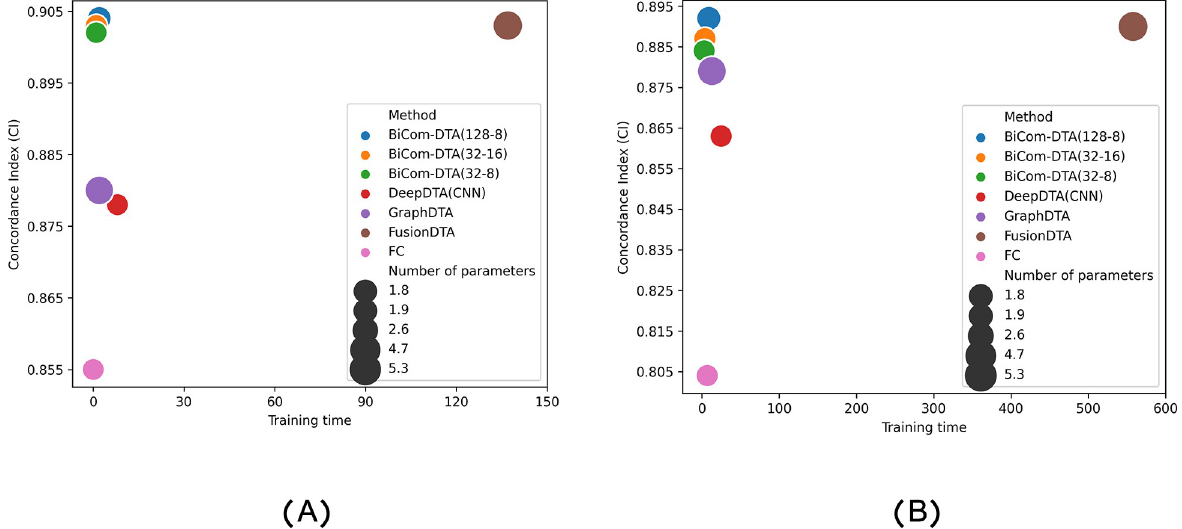
Fig 7. Accuracy vs. training time on GPUs, and the number of parameters for BiComp-DTA and alternative methods. (A) Training time for Davis dataset, and (B) Training time for Kiba dataset.